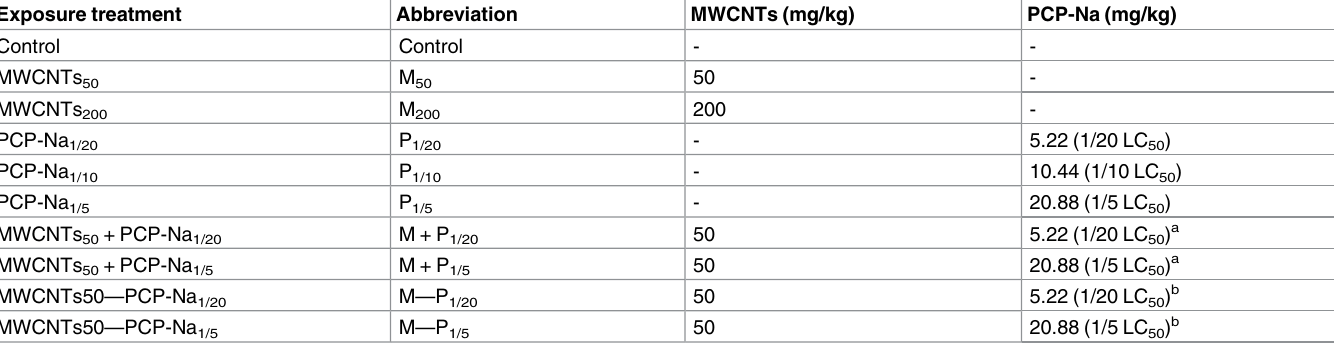
Table 1. Dosages of MWCNTs and/or PCP-Na used for oxidative damage and membranedamage. Exposure